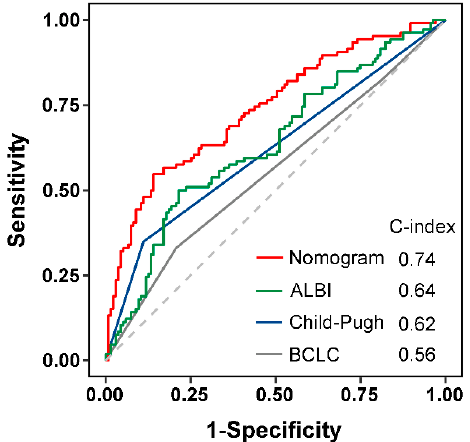
Figure 5. Comparison of predictive accuracy between ALBI score, Child − Pugh grade, BCLC, and the PGA grade. BCLC, Barcelona Clinic Liver Cancer staging; ALBI, albumin − bilirubin score; Child − Pugh, Child − Pugh grade.